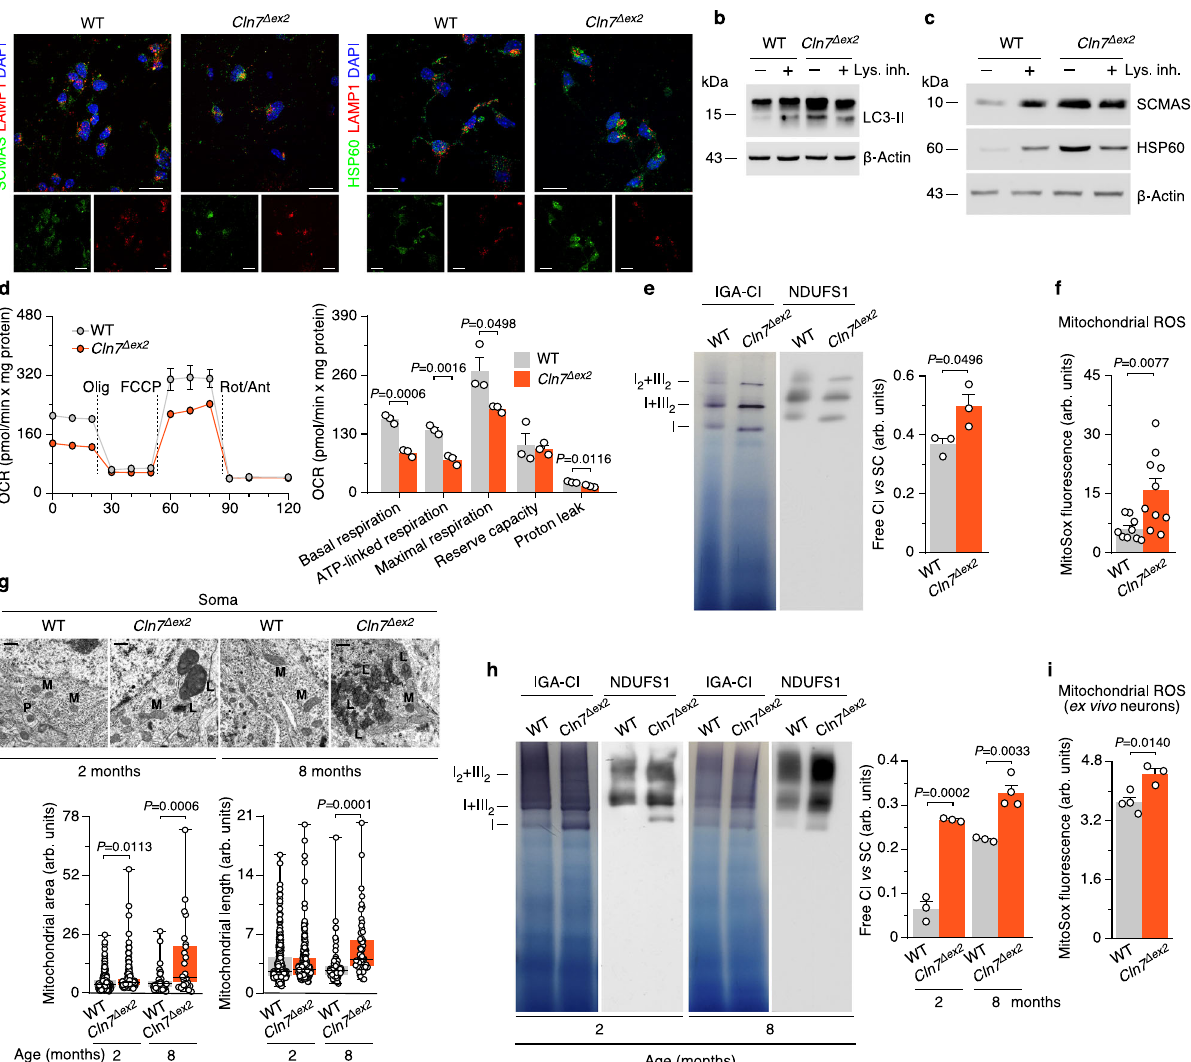
Fig. 1 Failure in autophagy causes accumulation of structural and functionally impaired mitochondria in Cln7 Δ ex2 mouse. a SCMAS/LAMP1 and HSP60/ SCMAS colocalization confocal analyses in primary neurons. DAPI reveals nuclei. Scale bar, 20 µ m. b LC3-II western blot analysis in primary neurons incubated with lysosomal inhibitors leupeptin (100 µ M) plus NH 4 Cl (20 mM) (Lys. Inh.) for 1 h (ß-actin, loading control). c HSP60 and SCMAS western blot analysis in primary neurons incubated with lysosomal inhibitors leupeptin (100 µ M) plus NH 4 Cl (20 mM) (Lys. Inh.) for 1 h (ß-actin, loading control). d OCR analysis (left) and calculated parameters (right) in primary neurons. Data are mean ± SEM from n = 3 independent experiments. e Free complex I (CI) and CI-containing supercomplexes (SC) analyses in primary neurons by BNGE in-gel activity (IGA-CI) and by immunoblotted PVDF membranes against CI subunit NDUFS1. Data are mean ± SEM from n = 3 independent experiments. f Mitochondrial ROS analysis in primary neurons. Data are mean ± SEM from n = 9 (WT), n = 10 ( Cln7 Δ ex2 ) independent experiments. g Representative electron microscopy images and analyses of mouse brain cortex mitochondria. Data are in box plots (the box extends from the 25th to 75th percentiles, the horizontal line indicates the median, and the whiskers go down to the smallest value and up to the largest) from n ≥ 27 mitochondria per condition. Scale bar, 500 nm. (M mitochondria, L lysosome, P peroxisomes). h Free CI and CI-containing SC analyses of mouse brain cortex by BNGE IGA-CI and by immunoblotted PVDF membranes against NDUFS1. Data are mean ± SEM from n = 3 or n = 4 ( Cln7 Δ ex2 ) 8-month old animals. i Mitochondrial ROS analysis in freshly isolated mouse brain cortex neurons. Data are mean ± SEM from n = 3 or n = 4 (WT) animals of 6-month old. Statistical analyses were performed by two-tailed Student ’ s t test. Representative images and western blots out of n ≥ 3 experiments are shown. See also Supplementary Fig. 1. Source data are provided as a Source Data fi